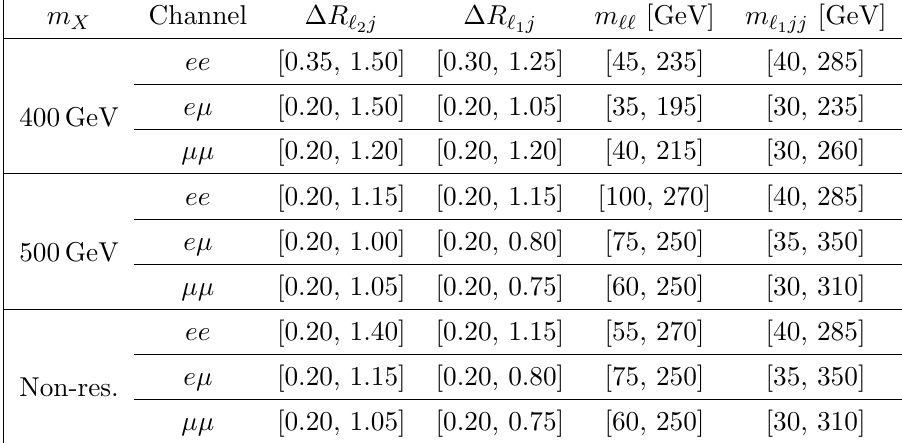
Table 7 . Description of the notation used in the three lepton analysis.